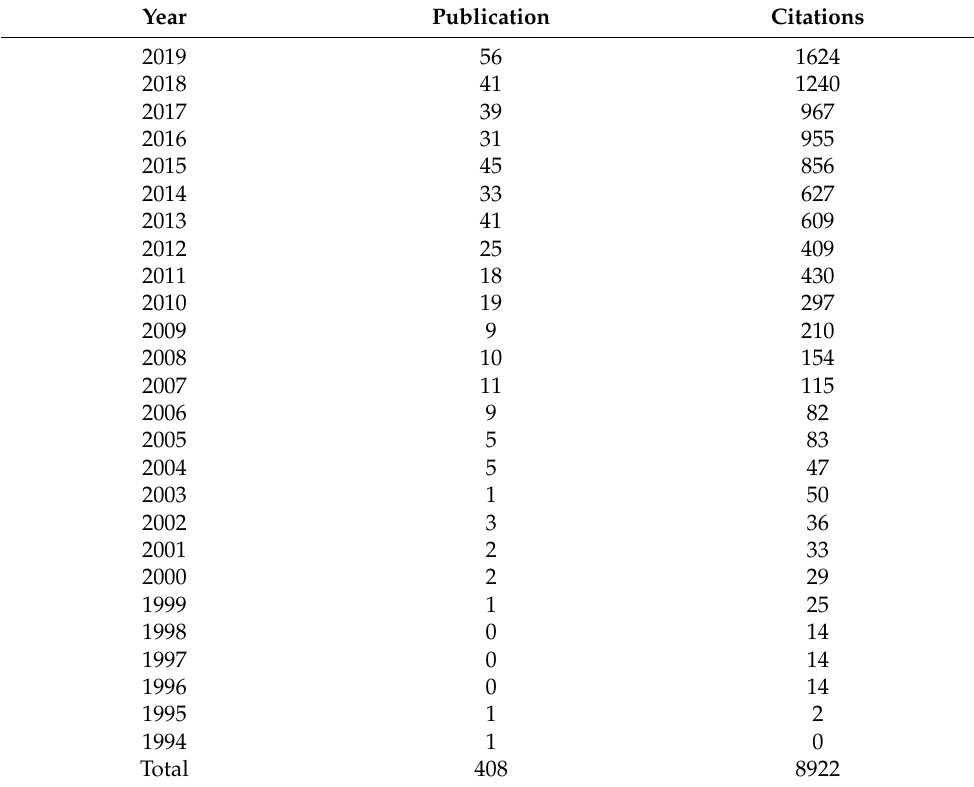
Table 1. Trends of publication and